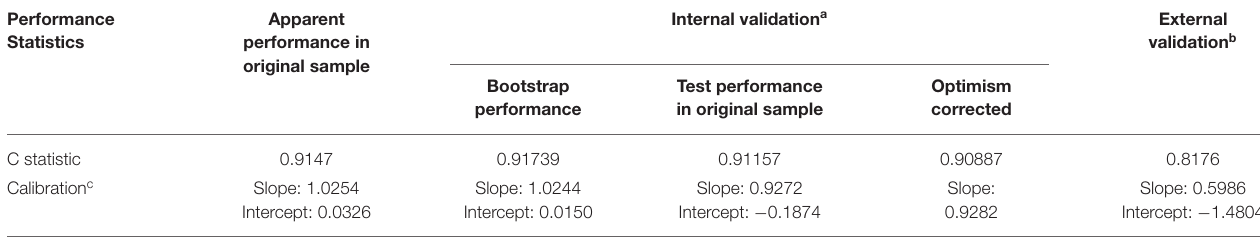
TABLE 3 | Apparent and validation performance of prediction model.